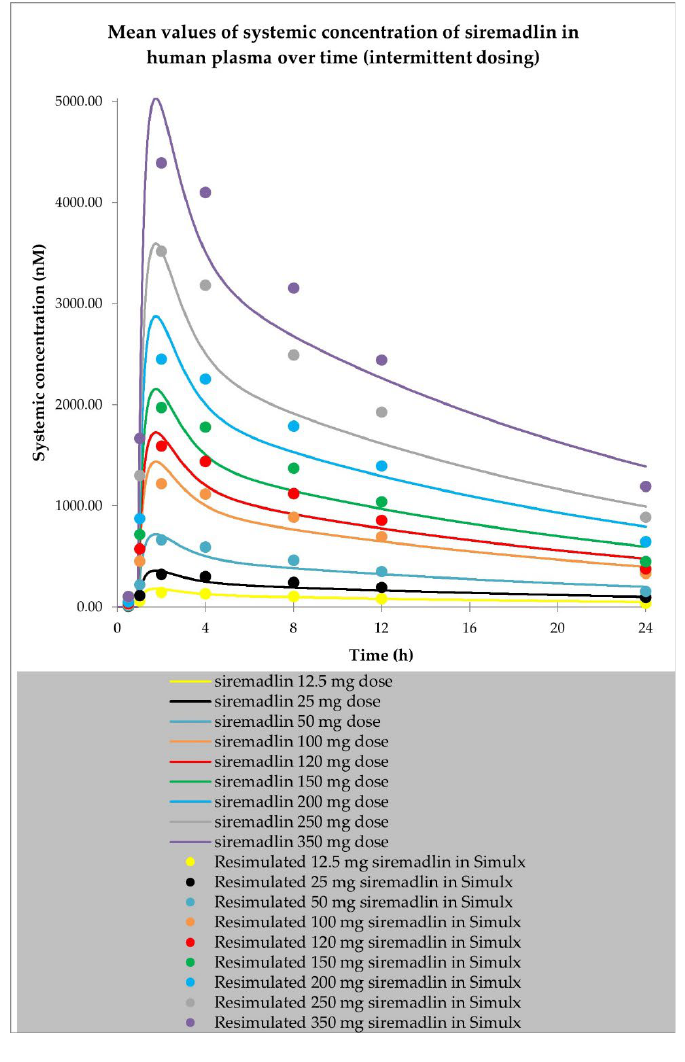
Figure 1. PBPK model of siremadlin administered in an intermittent regimen in cancer patient representatives using first-order absorption mechanism. Resimulated data are presented as a geometric mean from number of study participants × 10 (see Table 7 in Materials and Methods section).